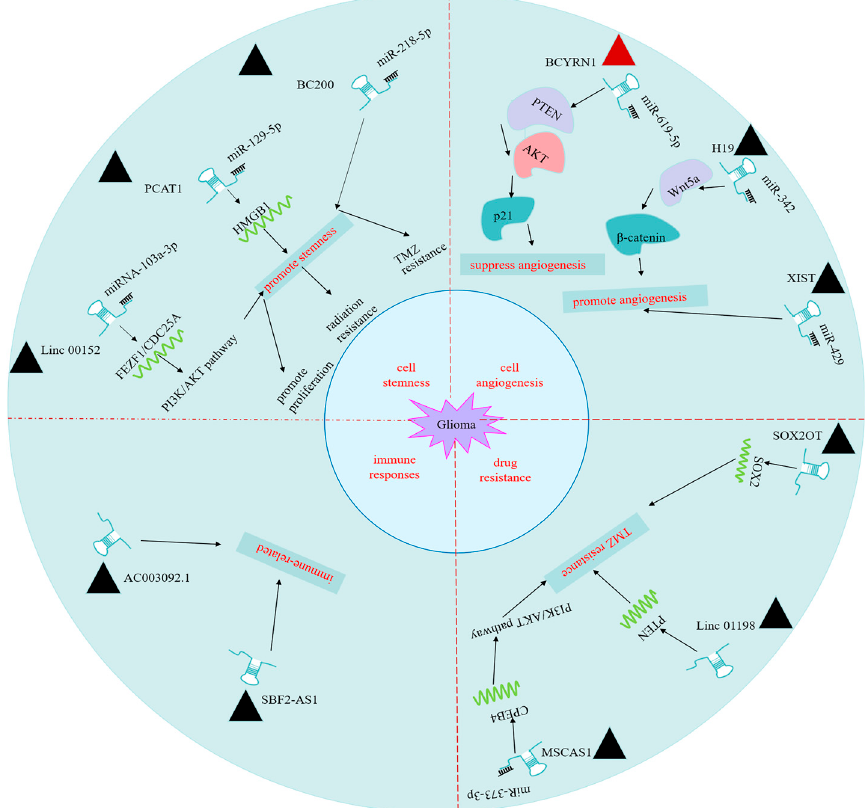
Figure 3. Biological function of some important lncRNAs in glioma. represents the oncogene, represents the tumor suppressor gene.